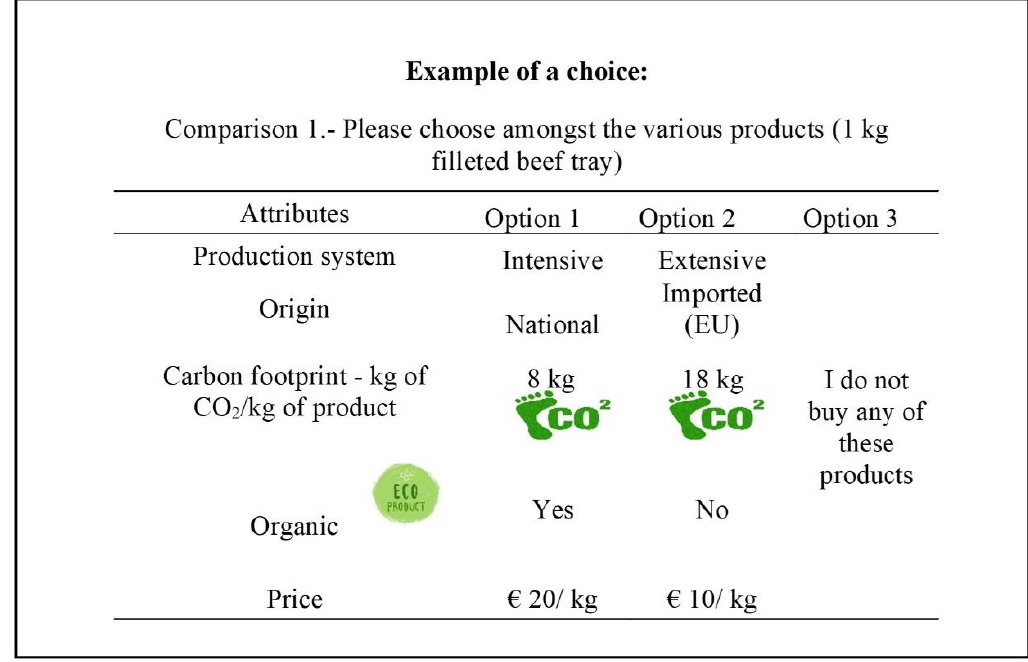
Figure 1. Illustration of an example of a choice set included in the questionnaire.